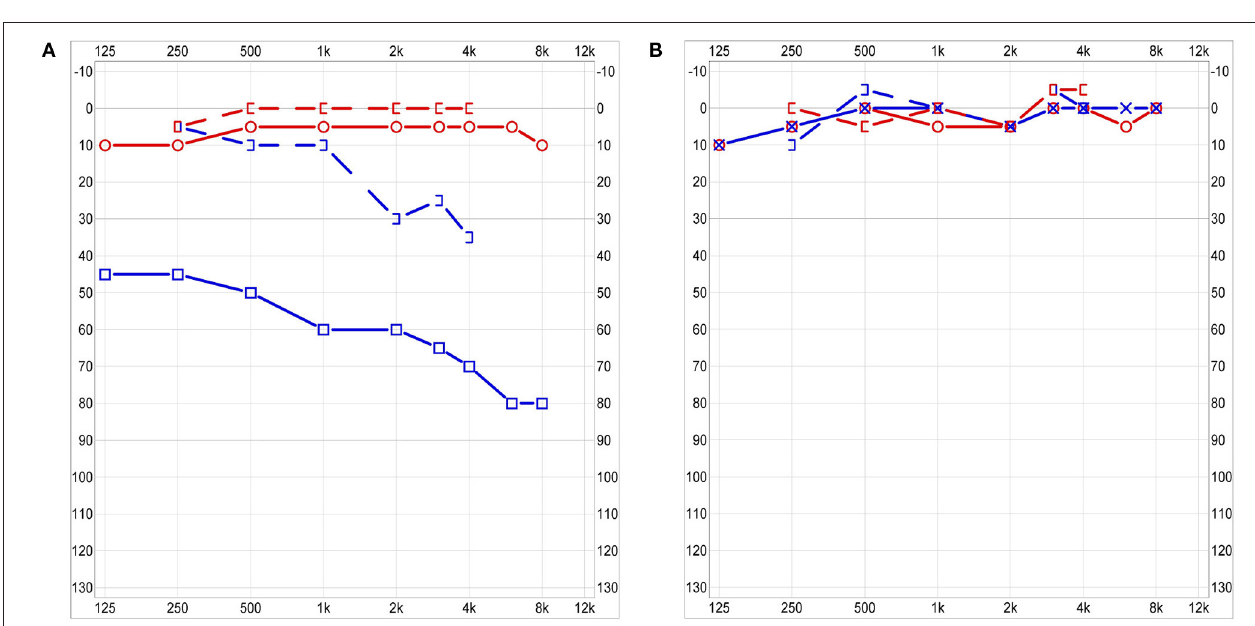
FIGURE 3 | Coronal view T1 DIXON FS post gadolinium, slice thickness 3mm. Arrow: Cavernous sinus, Triangle: Pars cavernosa of the internal carotid artery. Initial MRI: Thrombosis of the cavernous sinus and involvement of the internal carotid artery with hyperemia of the vasa vasorum (A) . MRI 7 days post-admission: Increasing inflammation of the internal carotid artery with further reduction in lumen size (B) . MRI 14 days post-admission: Improvement of internal carotid artery involvement with a partial recovery in size (C) . MRI 3 months post-admission: Complete recanalization of the left cavernous sinus and normal size of the left internal carotid artery (D) .